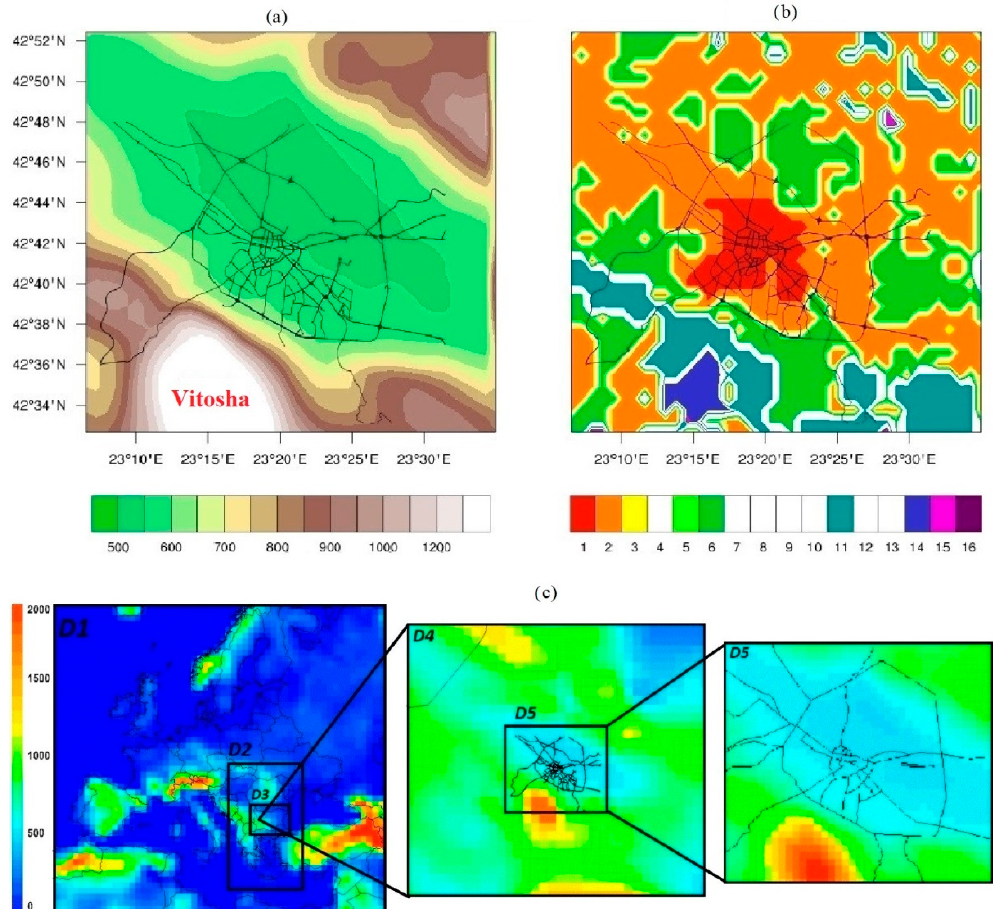
Figure 1. Domain elevation in (m) ( a ). Land cover ( b ) categories: 1—Urban and Built-up Land; 2—Dryland Cropland and Pasture; 3—Irrigated Cropland and Pasture; 5—Cropland/Grassland Mosaic; 6—Cropland/Woodland Mosaic; 11—Deciduous Broadleaf Forest; 14—Evergreen Needleleaf; 15—Mixed Forest; 16—Water Bodies. Elevation (m) of five nested domains ( c ).